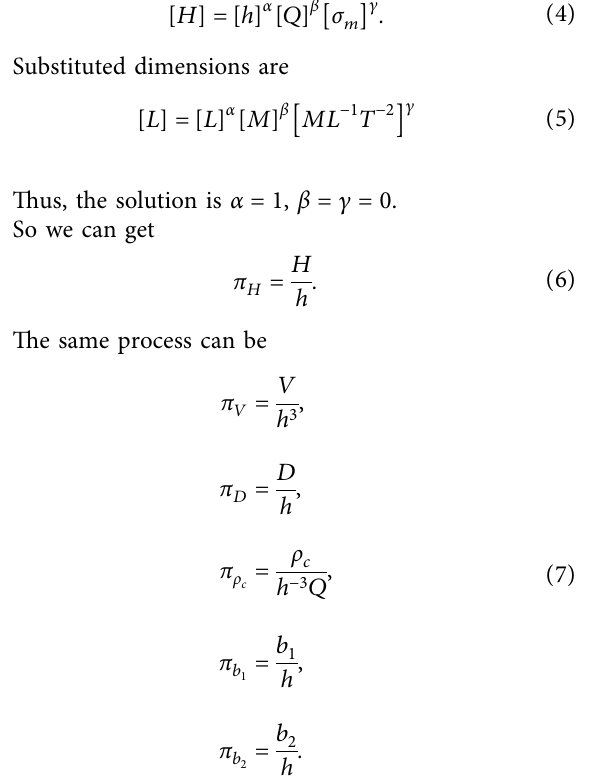
the blast hole and the distance between the orifices are fixed.